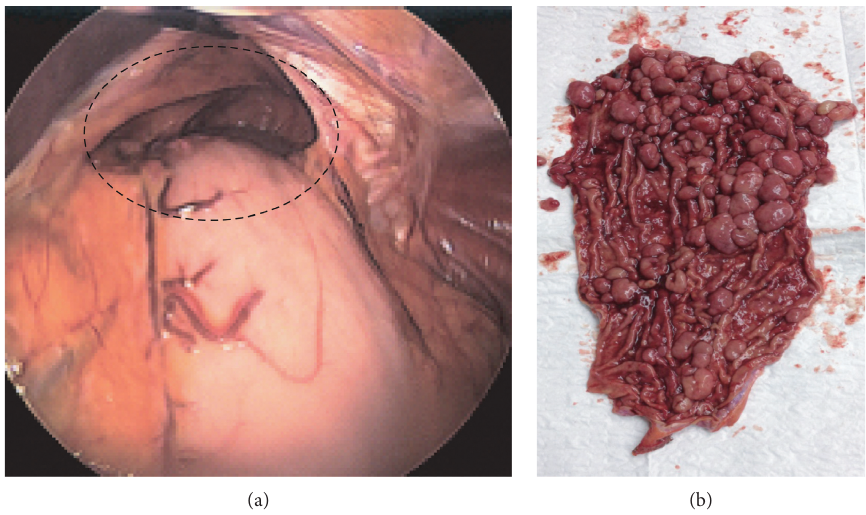
Figure 2: (a) Laparoscopy: large paraesophageal hernia. (b) Opened specimen: fundus gland